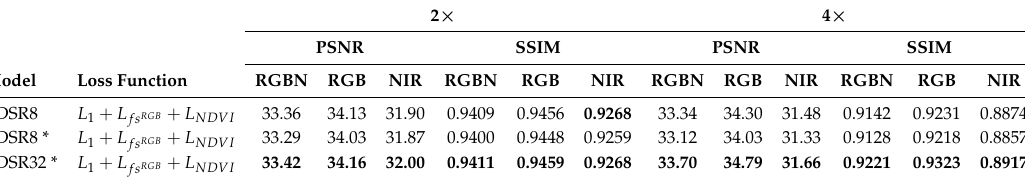
Table 10. PSNR and SSIM metrics obtained with EDSR8 and EDSR32 using multiple GPUs and TTA in the test set. 2 × 4